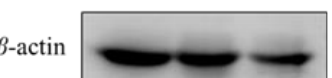
Figure 7. Relative expression levels of FAF1 protein in ovaries of different reproductive cycles (dif- ferent letters indicate significantly different values at p < 0.05). 3.6. Localization of FAF1 Protein Expression in Ovaries of Different Reproductive Cycle Phases The immunohistochemical staining results (Figure 8) showed that FAF1 protein was positively expressed (in brown) in testes of Bos grunniens at different ages. The distribution sites were similar among ages, comprising spermatozoa, spermatocytes, spermatogonia, primary spermatocytes, supporting cells, testicular interstitial cells, peritubular myeloid cells and germinal tubules. Figure 8. Localization of FAF1 protein expression in ovaries of different reproductive cycle phases. ( A – F ) Immunohistochemical staining. ( A – C ) Positive expression of FAF1. ( D – F ) Negative control of